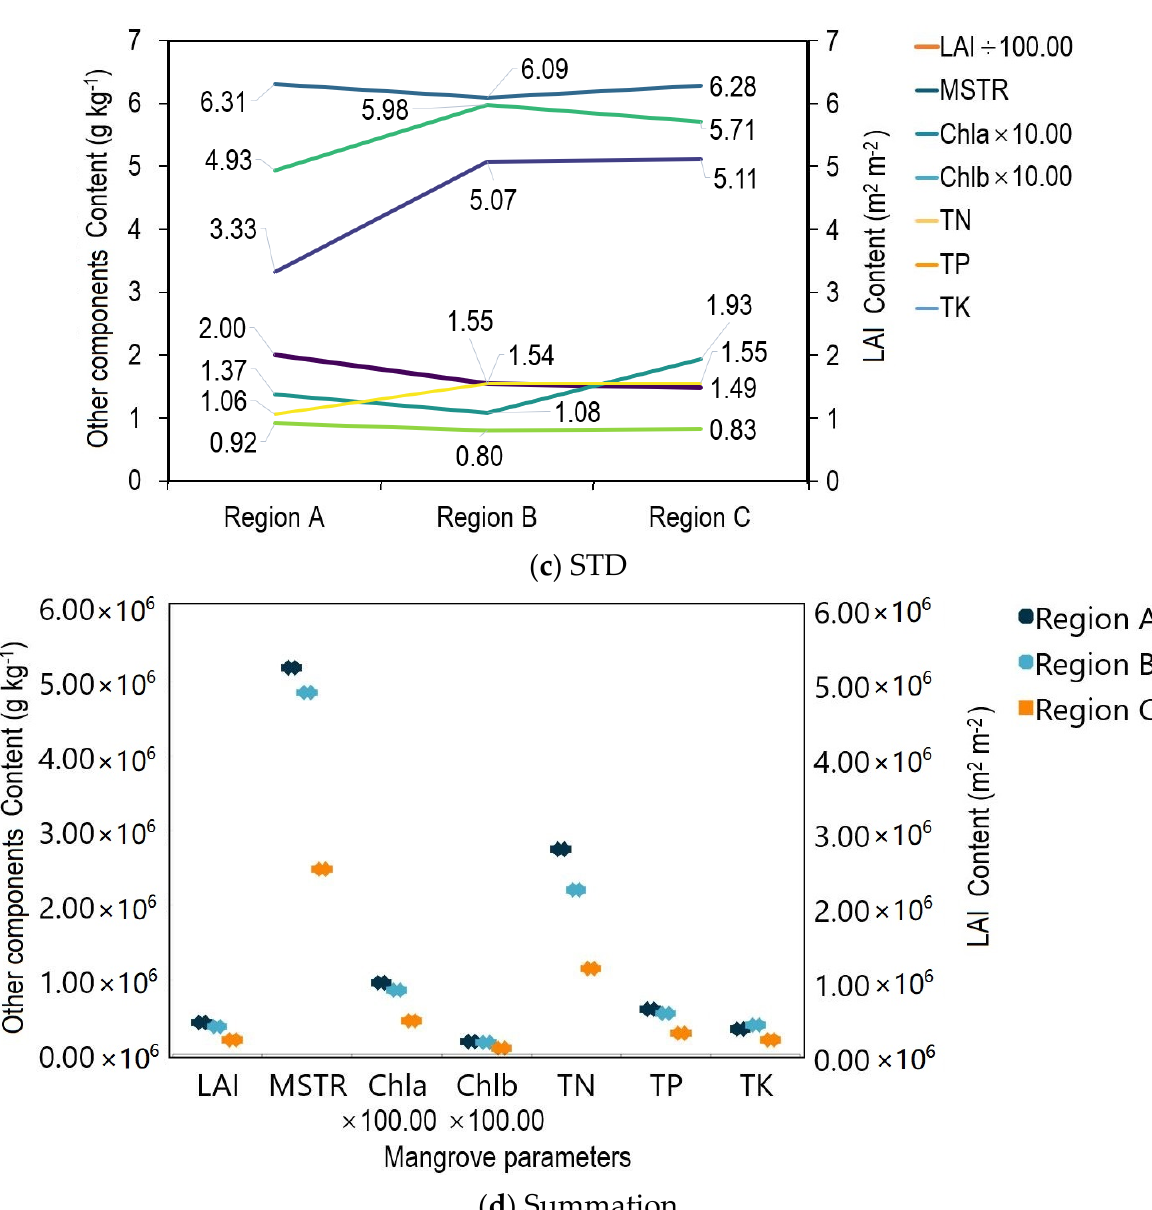
Figure 5. Statistical results of mangrove main nutrient contents in different regions. ( a ) There is no significant difference in the average nutrient content of the three regions, which is in the same order of magnitude; ( b ) the maximum values of the other six substances in the three regions is close in addition to the content of total potassium; ( c ) the maximum STD values of LAI and total nitrogen are large, and the other five substances have little difference in the three regions; ( d ) in terms of total content, the content of various components in region A is significantly higher than that in the other two regions. However, the content of total potassium in region B is the highest.